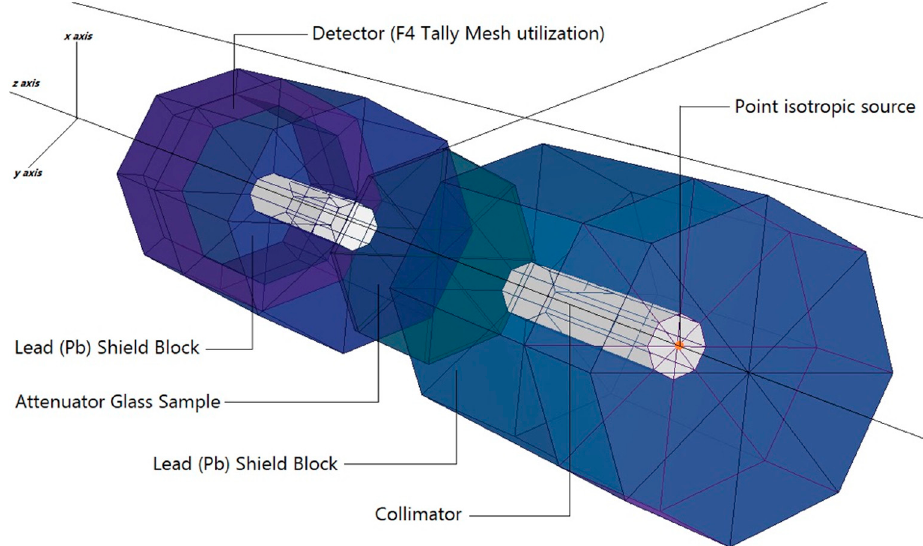
Figure 3. 3-D view of designed MCNPX simulation setup for gamma ray transmission competencies of VPB x Cu y glasses (obtained from MCNPX Visual Editor VE VisedX22S) .